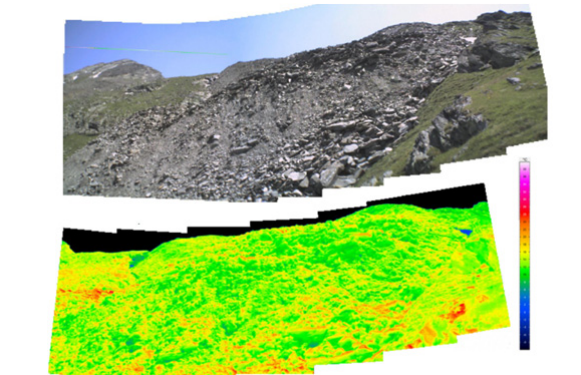
Figure 11: Stitched thermography panorama at Hochebenkar rock